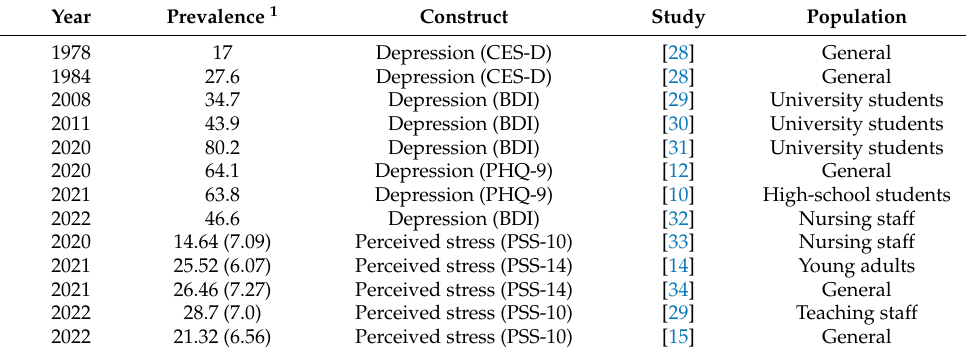
Table 3. Descriptive Statistics of the Dependent Variables Across Genders.